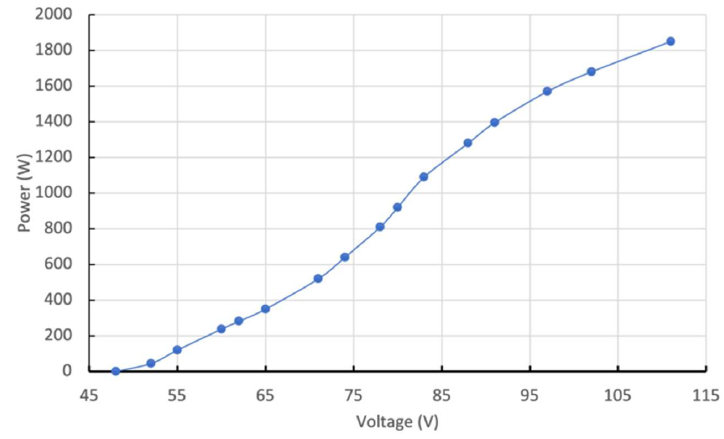
Figure 11. Example of a DC voltage curve vs. reference power on a TriStar controller [50].